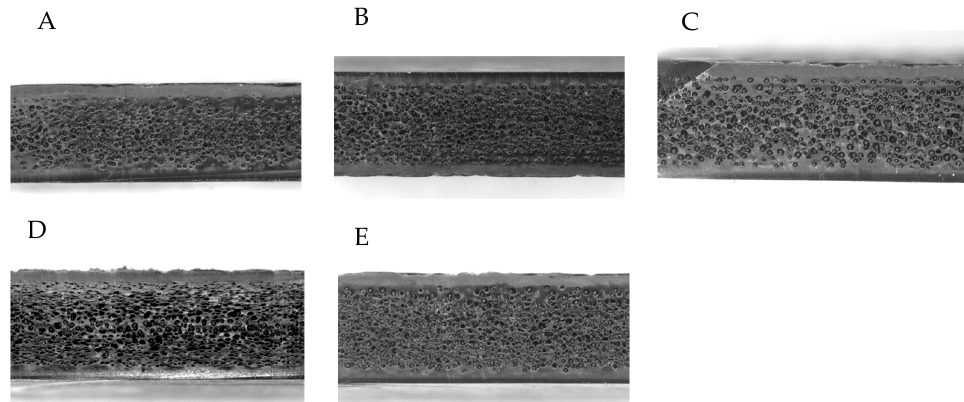
Figure 2. Structure core/skin in specimens cut from the core-back injection molded part. ( A – C ): specimens cut from the same position on the part, from parts 2.8 mm, 3.0 mm, and 3.2 mm, respectively. ( D , E ): Specimens cut from 3.2 mm thick parts from other different positions.